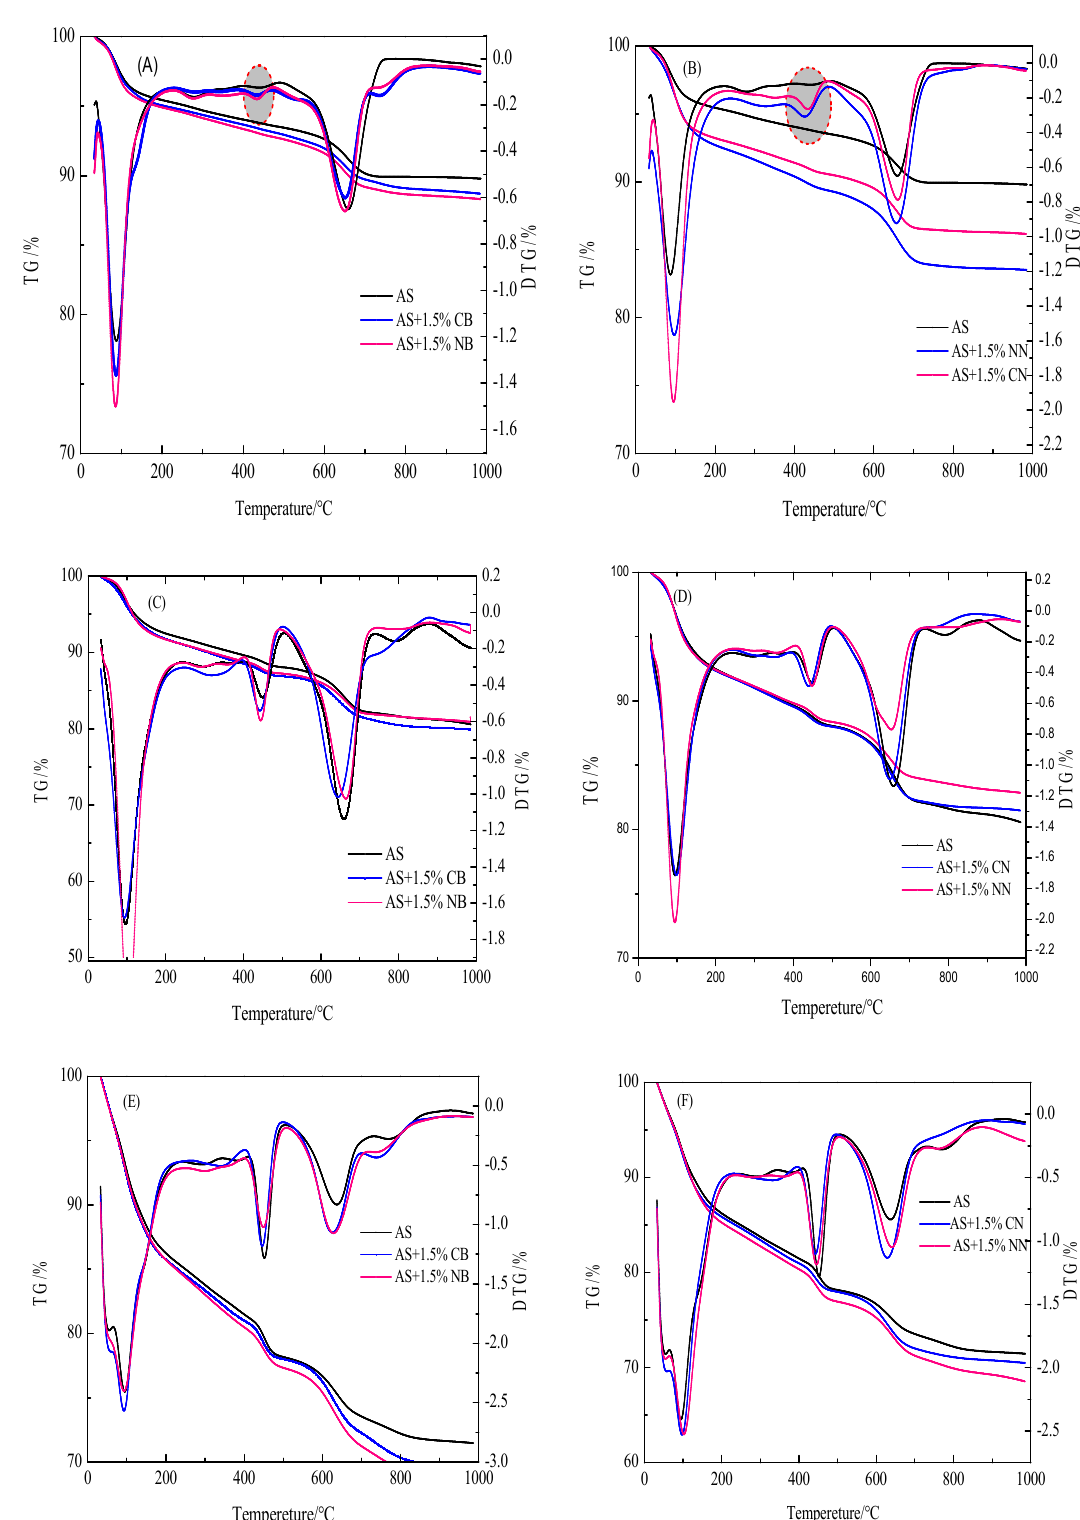
Figure 6. DG/DTG of hydration products: ( A , B ) hydration products of the cement paste added with CB/CN and NB/NN for 12 h; ( C , D ) hydration products of the cement paste added with CB/CN and NB/NN for 24 h; ( E , F ) hydration products of the cement paste added with CB/CN and NB/NN for 28